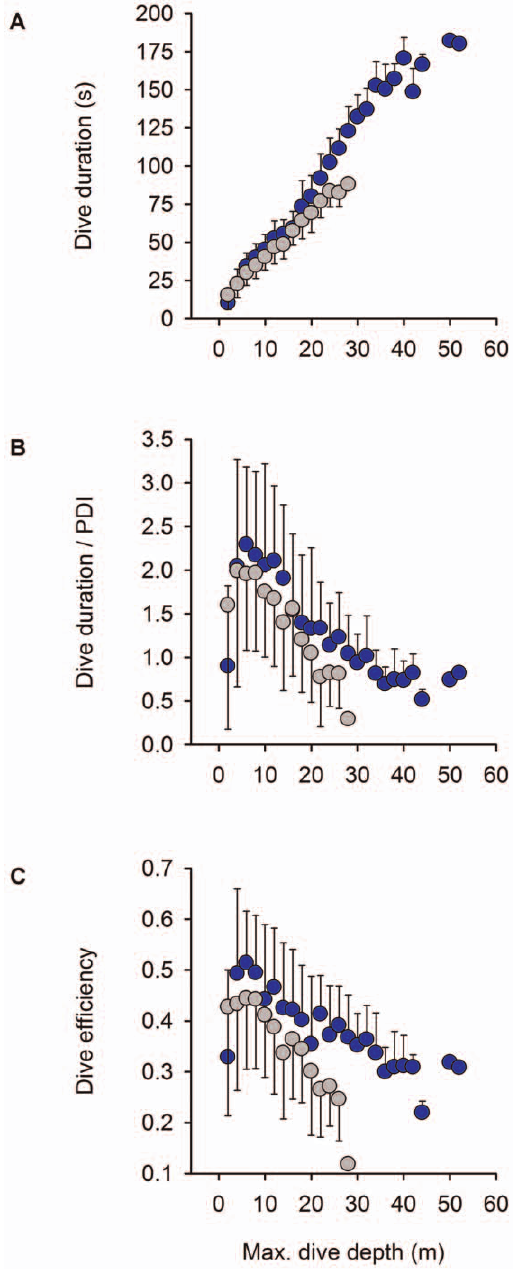
Figure 5. Differential diving capacity between sexes according to depth in the Kerguelen Shag. Effect of dive depth on (A) dive duration, (B) dive to surface ratio and (C) dive efficiency in birds from the Maye`s colony. PDI is the post-dive interval and dive efficiency is calculated as bottom duration/(dive duration + post 2 dive interval). Females are in grey, males in blue. doi:10.1371/journal.pone.0056297.g005 optimal body size [56]. In eco-physiological terms, the optimal body size for diving to a particular depth is the one that yields important return rates in time and energy-budget. Dive efficiency refers to the time spent at the bottom of a dive (thus foraging) relative to the time invested in the overall activity of diving. For all birds, the highest values of dive to surface ratio and dive efficiency were found for dives 5–10 m deep lasting 35–60 s (Figure 5B and